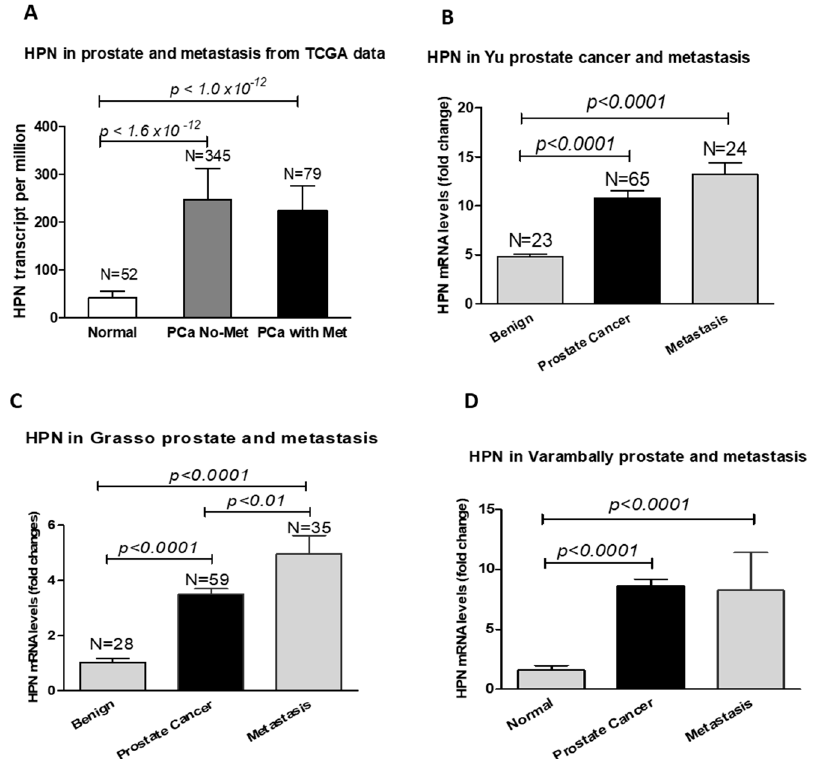
Figure 2. Hepsin mRNA levels were significantly increased in metastatic prostate tumors. ( A ) TCGA prostate cancer dataset. ( B ) The data from Yu’s study. ( C ) The data from Grasso’s study. ( D ) The data from Varambally’s prostate cancer study.